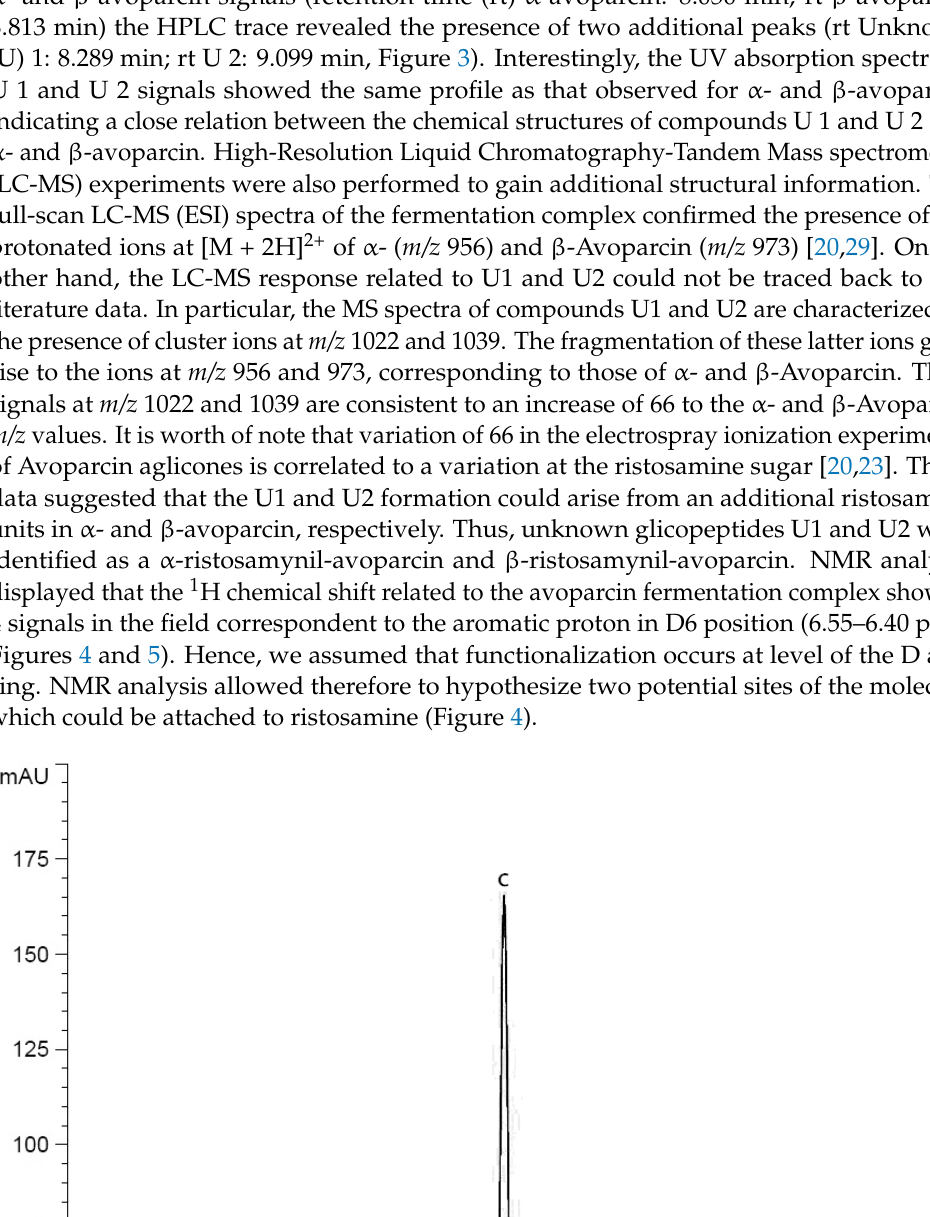
Figure 4. Chemical structure of avoparcin possible sites of attachment of the second ristosamine residue giving rise to the respective ristosamynil-avoparcin are shown by arrows. Functionalization occurs at the level of the D aryl ring.